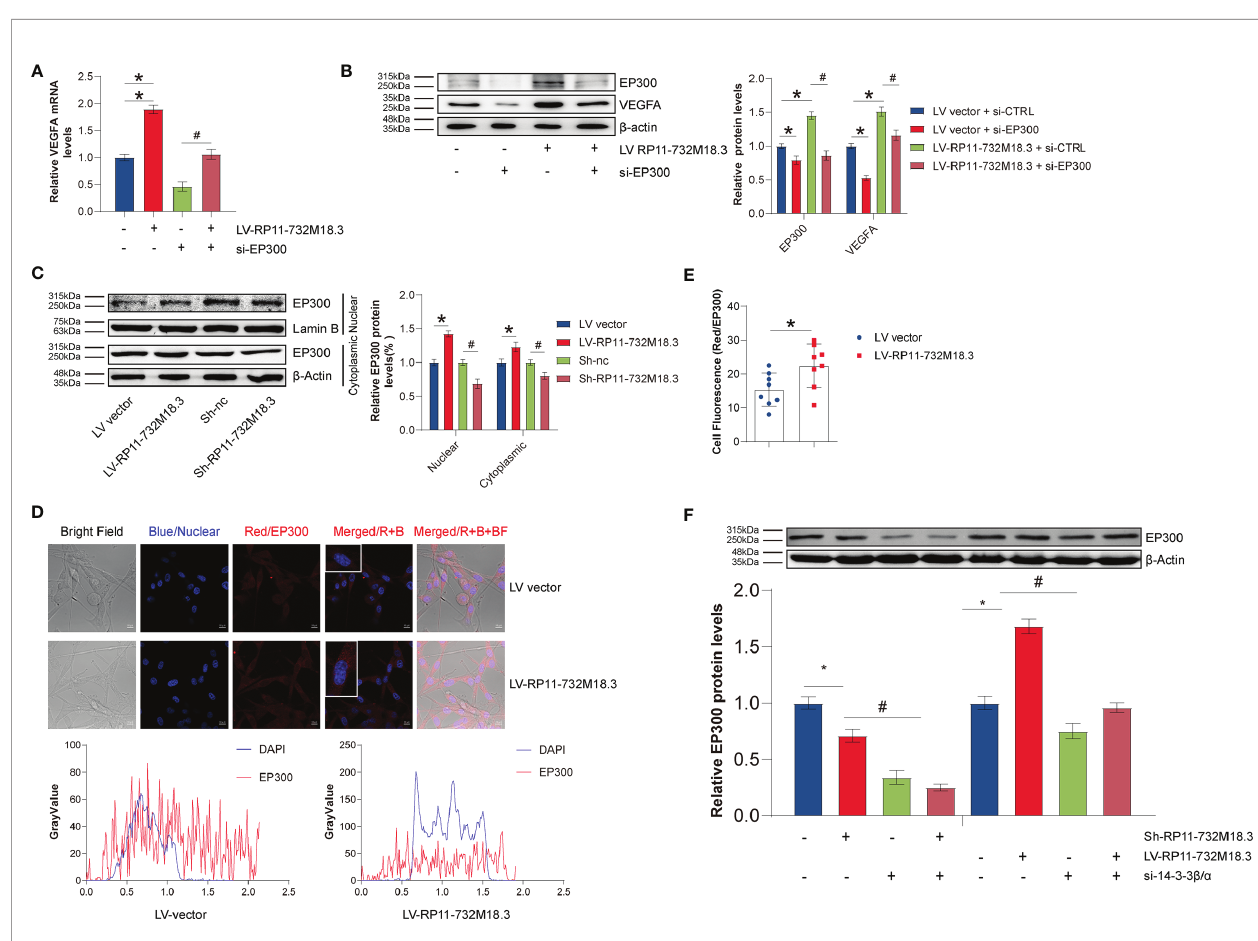
FIGURE 6 | lncRNA-RP11-732M18.3 increases VEGFA transcription through the 14-3-3 b /and EP300 pathways. (A) EP300 mediates lncRNA-RP11-732M18.3 regulation of VEGFA transcription as detected by RT-qPCR in indicated cells. All experiments were performed in triplicate (n = 3, *p < 0.05). (B) EP300 mediates the regulation of VEGFA by lncRNA-RP11-732M18.3 as detected by WB in indicated cells. All experiments were performed in triplicate (n = 3, *p < 0.05). (C) The expression of EP300 in cytosolic and nuclear fractions was detected by WB in indicated cells. Lamin-B and b -actin were used as controls for cytosolic and nuclear fractions, respectively. lncRNA- RP11-732M18.3 promotes the nuclear translocate of EP300. All experiments were performed in triplicate (n = 3, *p < 0.05). (D) Immuno fl uorescence of EP300 in indicated treatment cells. (E) Quanti fi cation of immuno fl uorescence results. lncRNA-RP11-732M18.3 promotes the expression and nucleus translocation of EP300. All experiments were performed in triplicate (n = 3, *p < 0.05). (F) 14-3-3 b / a mediates the regulation of EP300 by lncRNA-RP11-732M18.3 as detected by WB in indicated cells. All experiments were performed in triplicate (n = 3, * p < 0.05). # p <